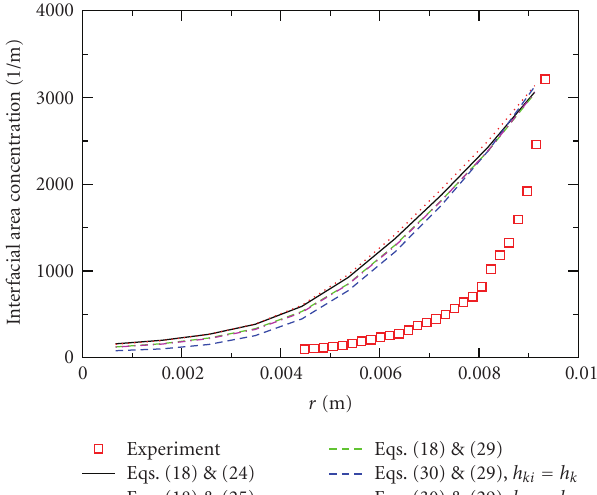
Figure 6: comparison of the di ff erent models on the mean diameter d 20